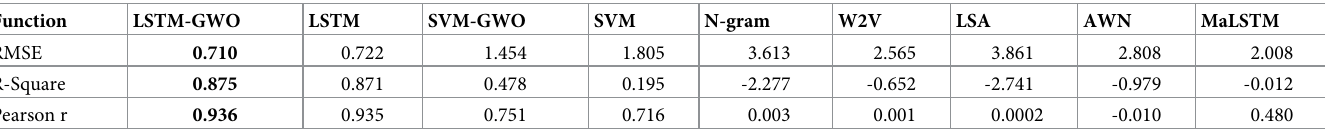
Table 9. Comparison of the proposed model and compared models with experiment